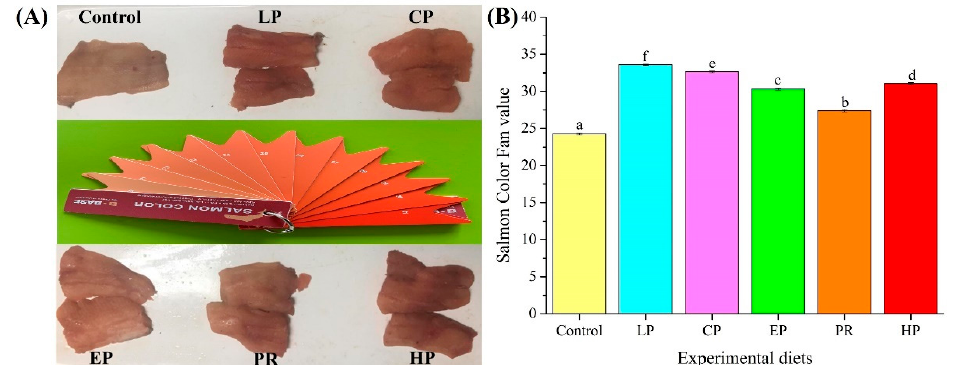
Figure 1. Comparison of pigmentation in the dorsal muscle of Oncorhynchus mykiss fed on an experimental diet for 56 days (( A ) Visual color inspection; ( B ) Salmon color fan value). The color value of fresh fillet in Oncorhynchus mykiss fed on experimental diets. Values are presented as mean ± SE, n = 12. Different letters represent statistical differences ( p < 0.05).